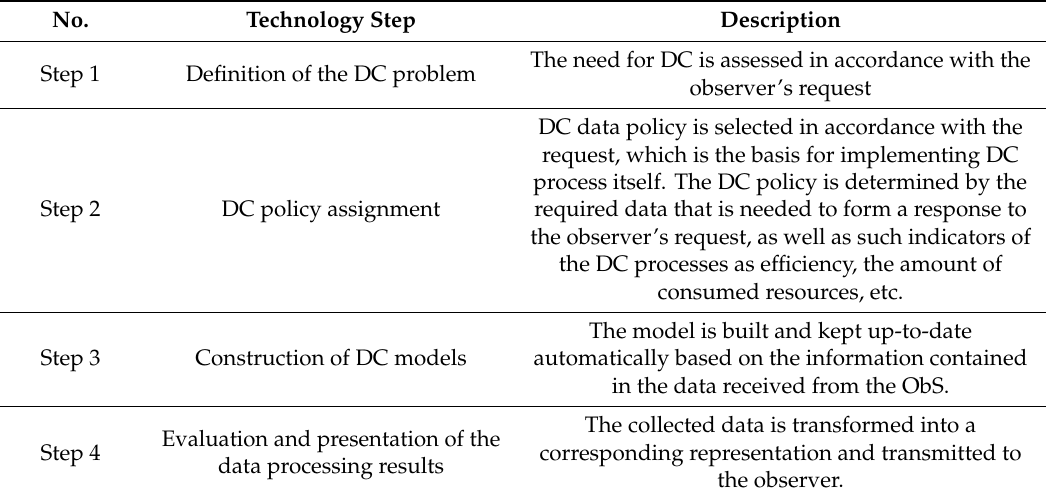
Table 2. Main steps for implementing the proposed technology.